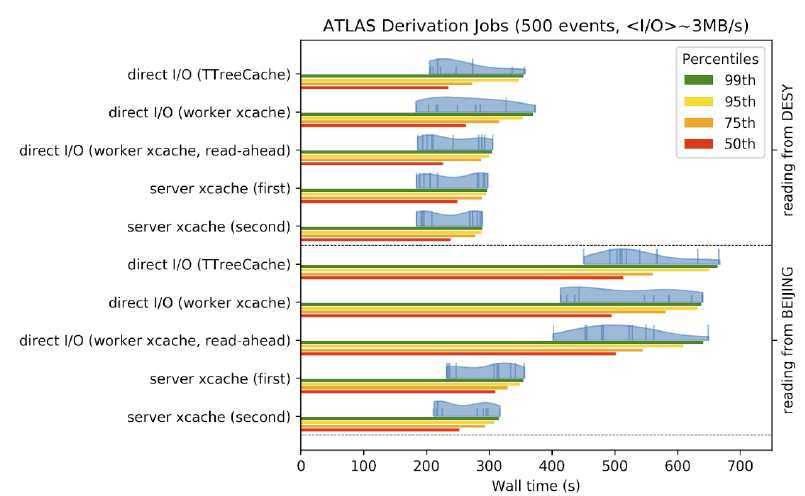
Figure 4. (center) XCache running on modest hardware at LMU. Successfully served 3.2k analysis and derivation jobs from ATLAS with and average I / O of 1 MB / s and 3 MB / s respectively. E ff ective latency hiding is achieved for high latency data